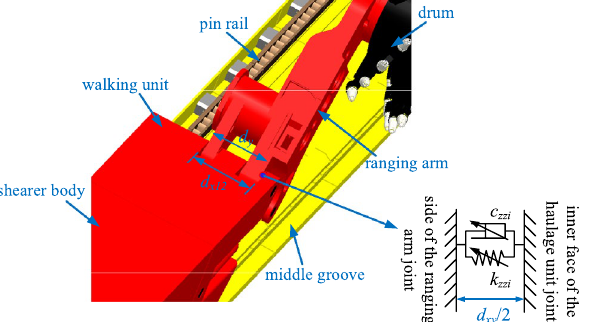
Figure 4. Schematic diagram of the connection between the ranging arm and the haulage